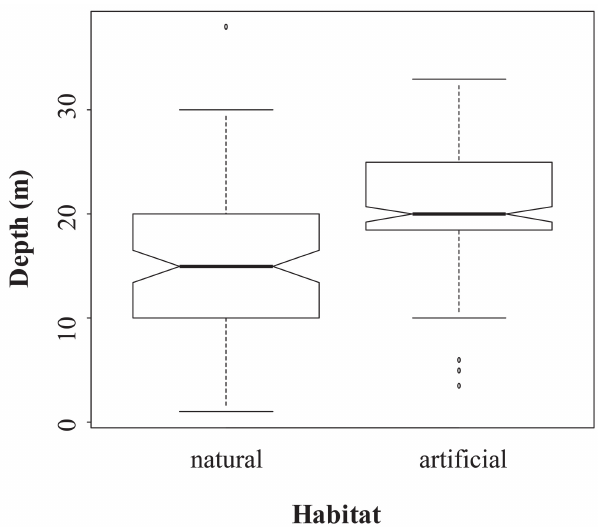
Fig. 3. Boxplots of median depth of sighted Epinephelus itajara at natural and artificial